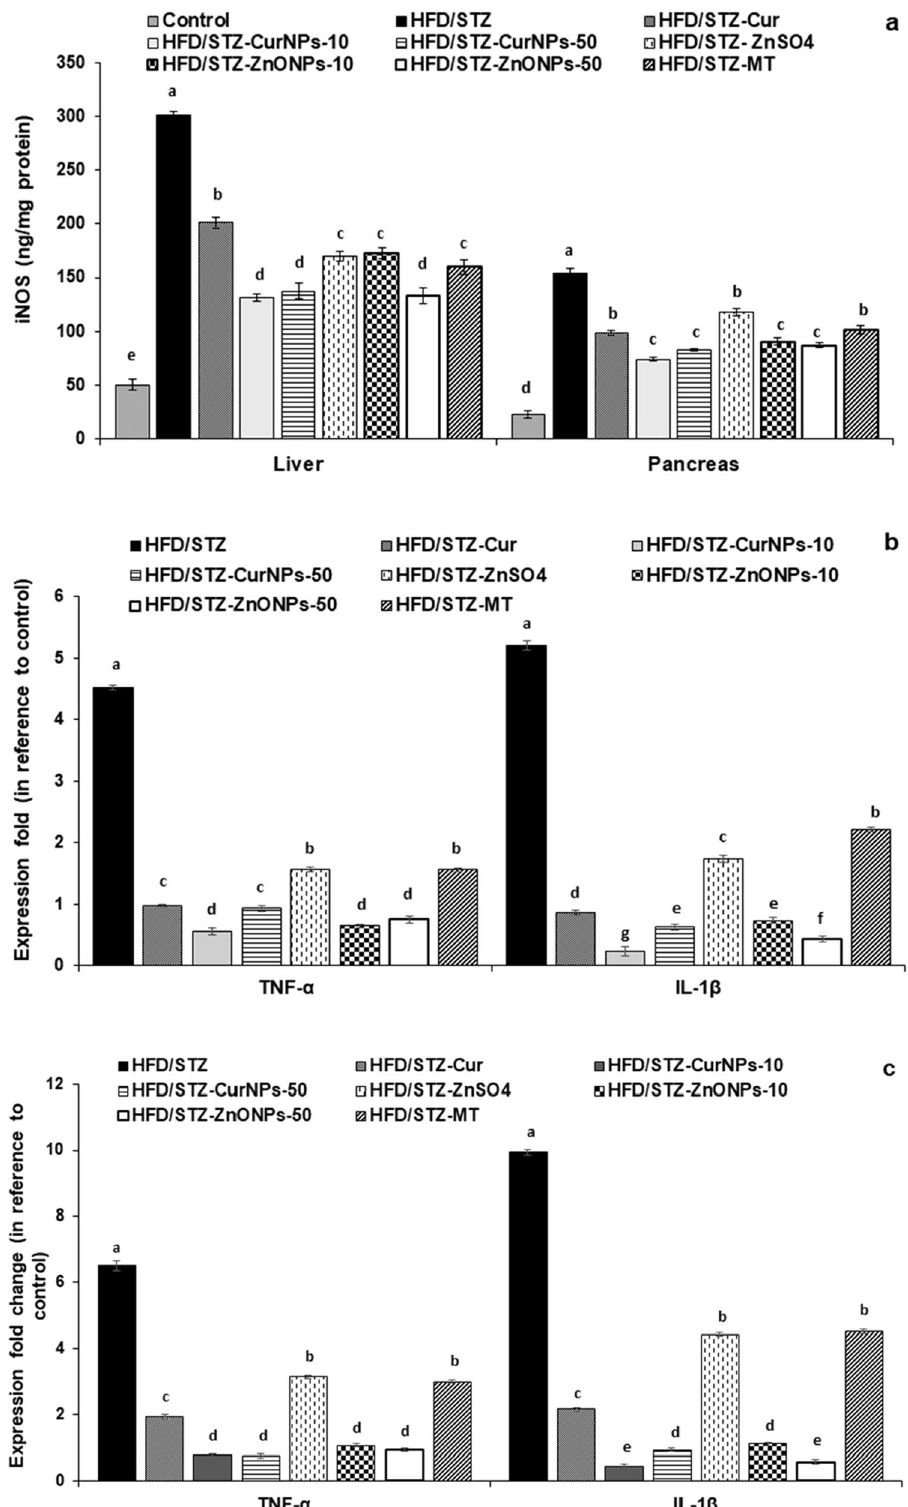
Figure 6. Inhibition of hepatic and pancreatic inflammatory response. ( a ): iNOS levels in liver and pancreas, ( b ): gene expression profile of TNF-α and IL-β in the liver, and ( c ): gene expression profile of TNF-α and IL-β in the pancreas of rats induced by HFD/STZ and treated by CurNPs and ZnONPs. Values are expressed as mean ± SEM (n = 7), means for the same tissue with different letters in each bar are significantly different (Tukey, p <